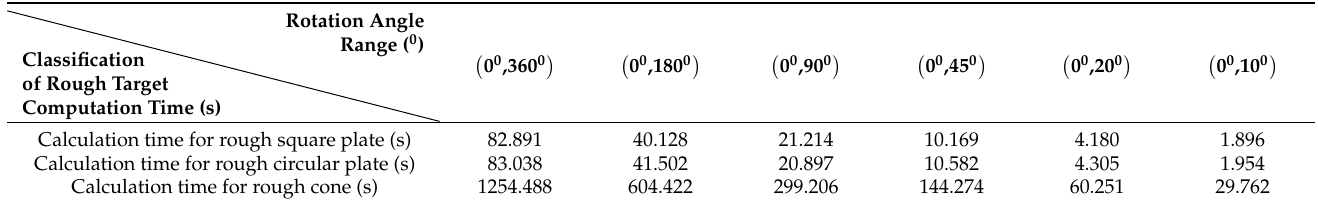
Table 1. Comparison of ISAL imaging times for rough square plate, rough circular plate, and rough cone at different rotation angles.